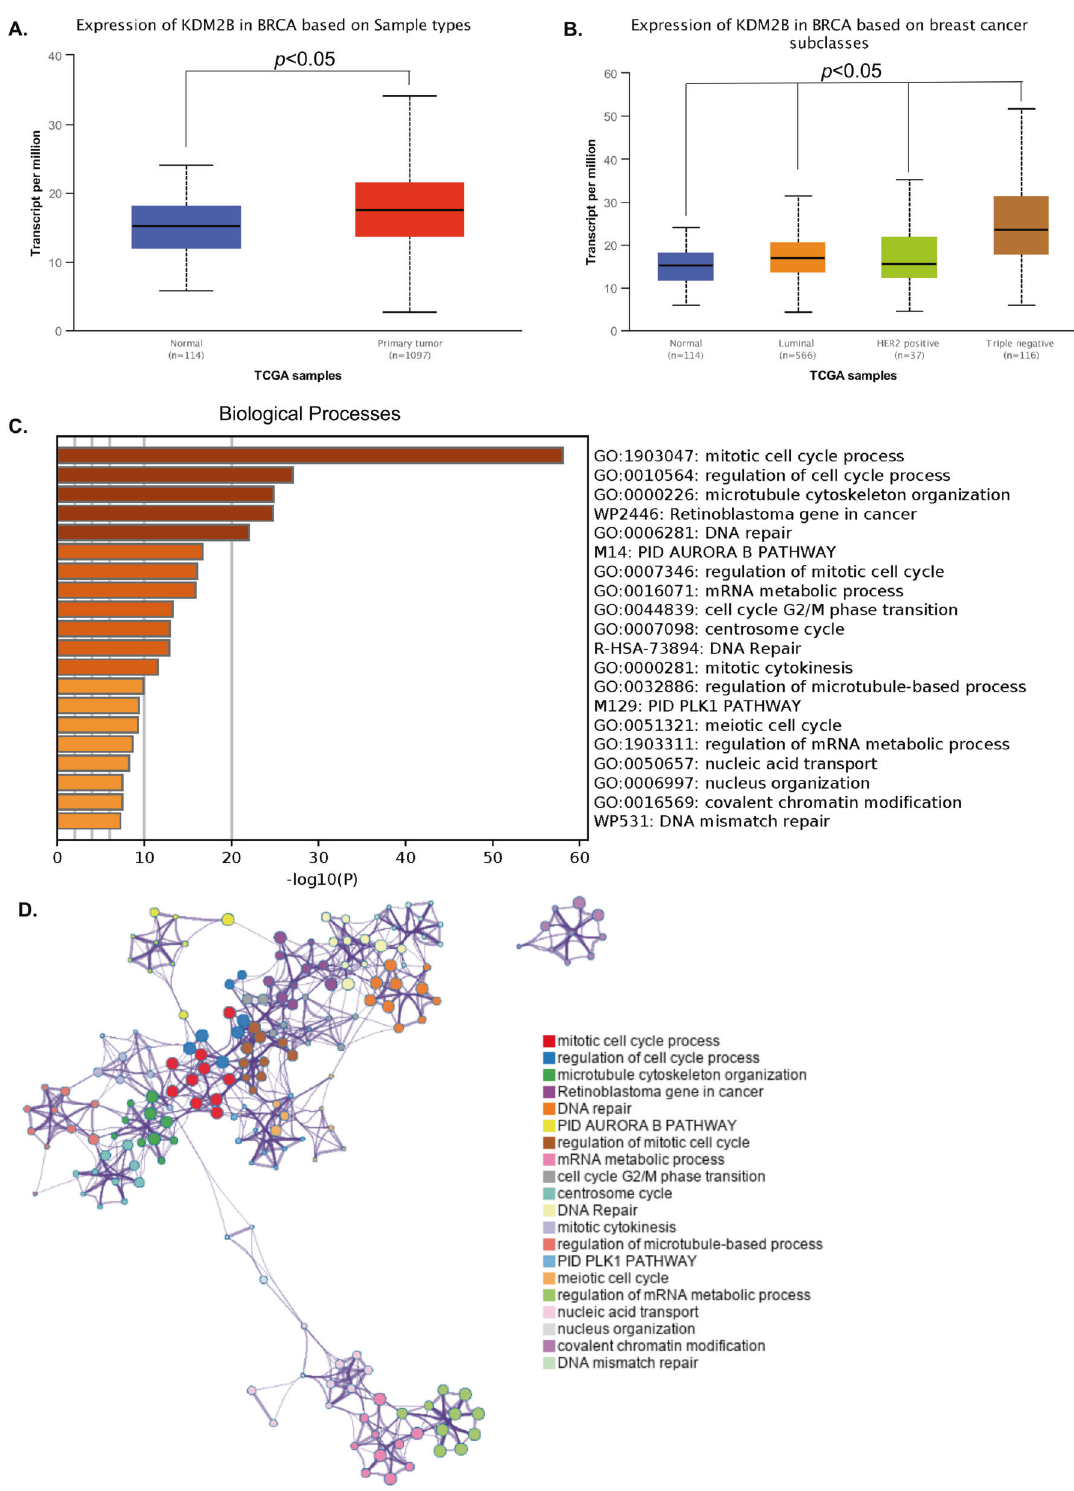
Fig. 1 Bioinformatics analysis of FBXL10 and its associated genes in breast cancer. A , B The expression of FBXL10 in breast cancer based on sample types ( A ) and major subtype ( B ), these data were analyzed and downloaded from UALCAN database (http://ualcan.path.uab.edu/). C , D . GO enrichment analysis ( C ) and cluster analysis ( D ) of biological processes of FBXL10 positively associated genes in breast cancer. The genes cluster was downloaded from UALCAN database and GO analysis was conducted with Metascape